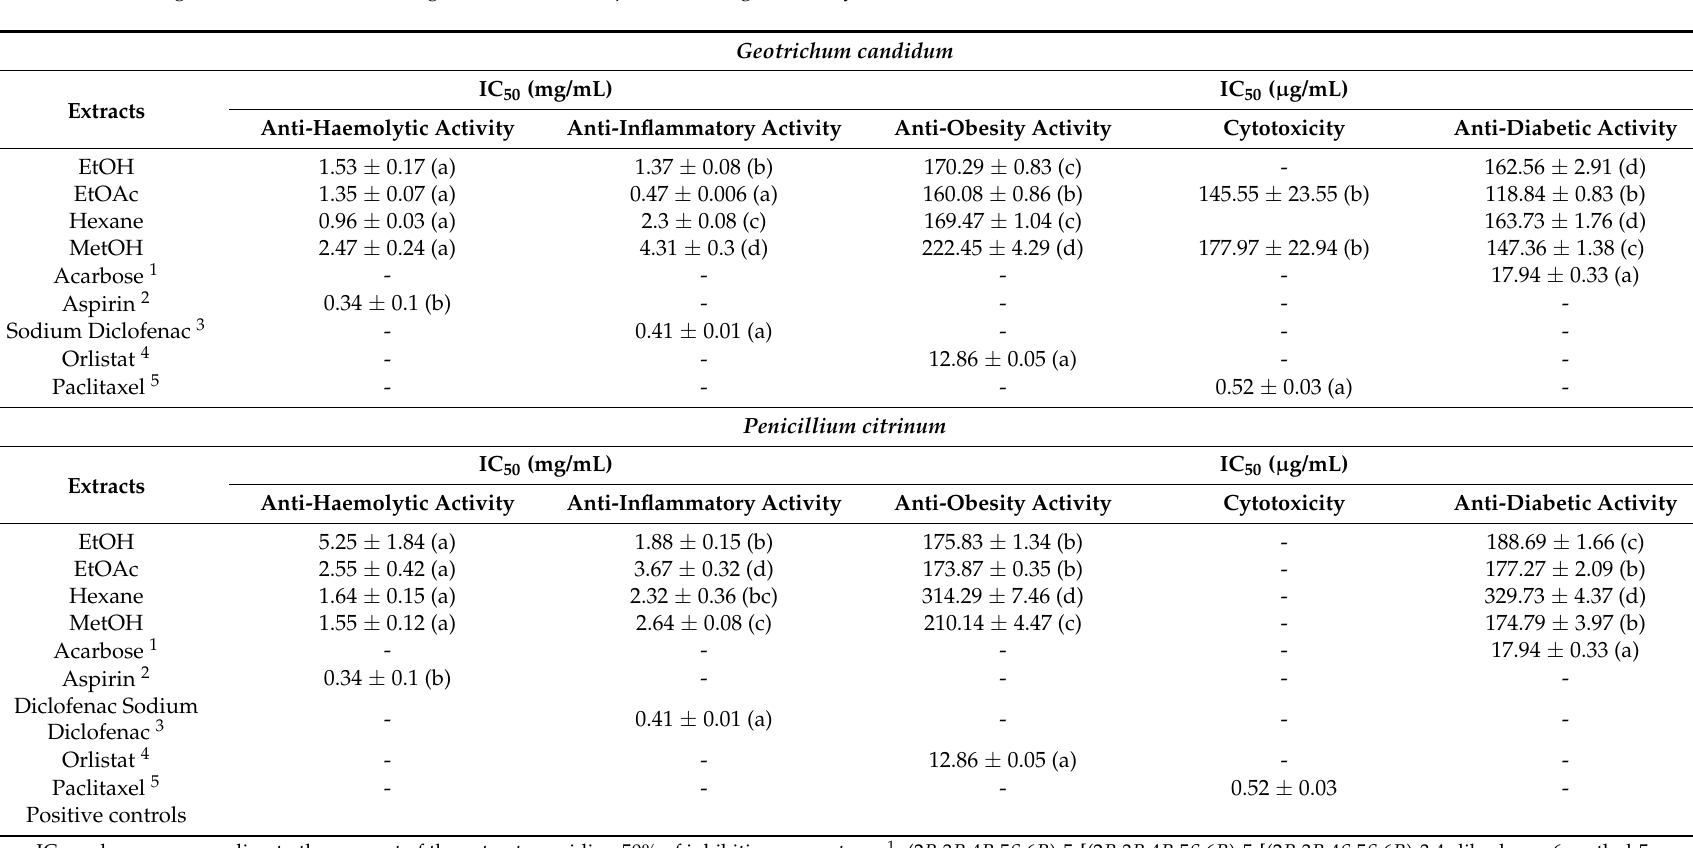
Table 1. Assessment of in vitro biological activities of Geotrichum and Penicillium extracts. Data presents mean ± standard error. Different letters inside of parenthesis indicate the significant difference among the treatments at p < 0.05 using the Tukey’s HSD